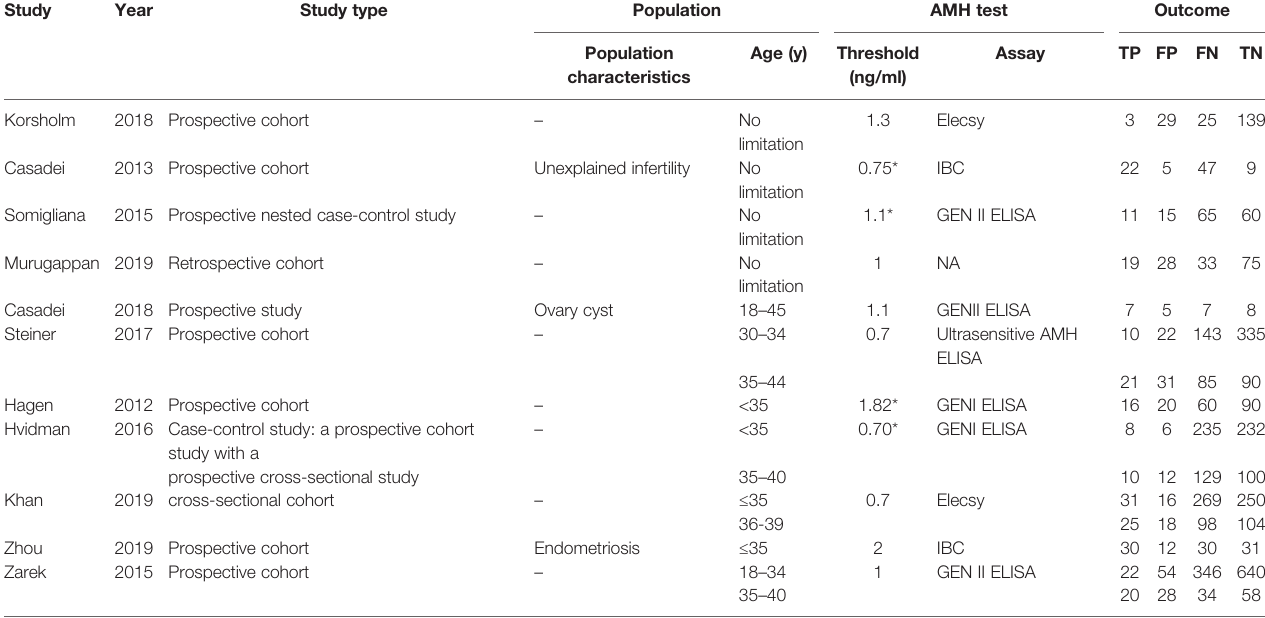
TABLE 1 | Characteristics of the studies included in the